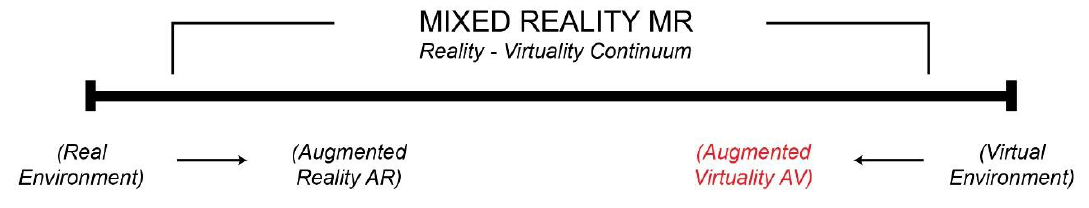
Figure 1. The continuum of the real and virtual worlds.